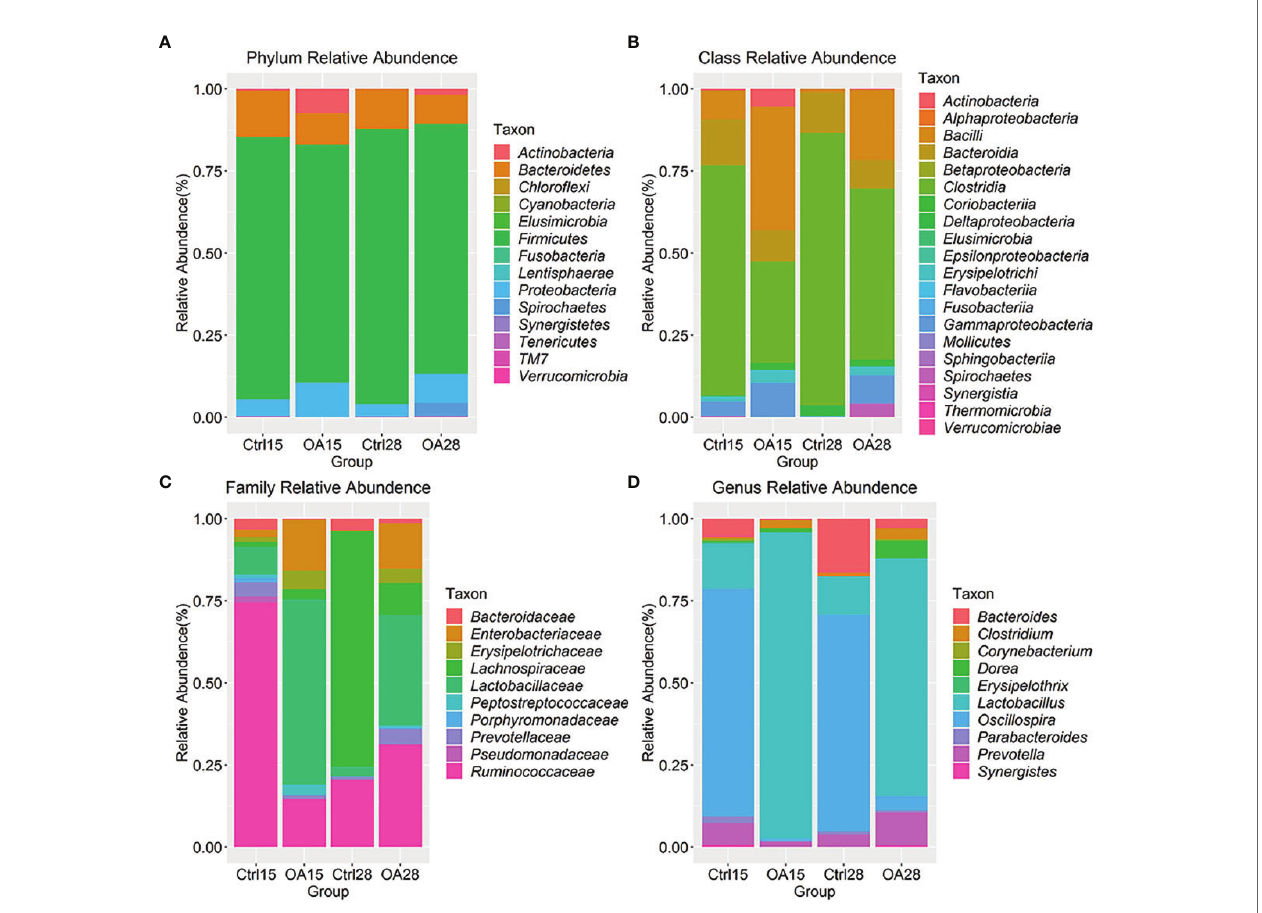
FIGURE 6 | The intestinal fl ora detail of piglets after L.casei treatment, microbiota at the Phylum level (A) , Class level (B) , Family level (C) and Genus level (D) were shown by bar plot. The top 20 taxons of Family and Genus abundance were taken to analyse the effect of probiotic L.casei on intestinal fl ora composition in